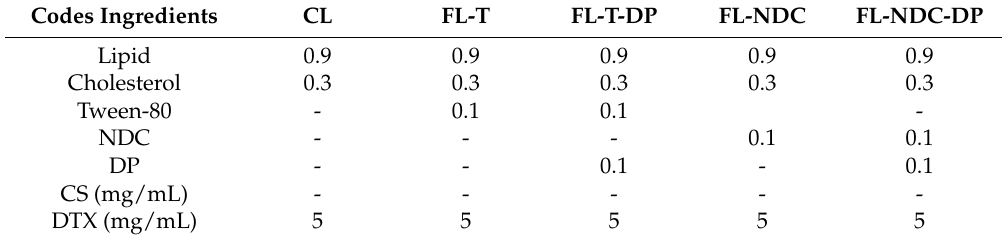
Table 1. The composition of docetaxel (DXT)-loaded liposomes. CL—conventional liposome; FL—